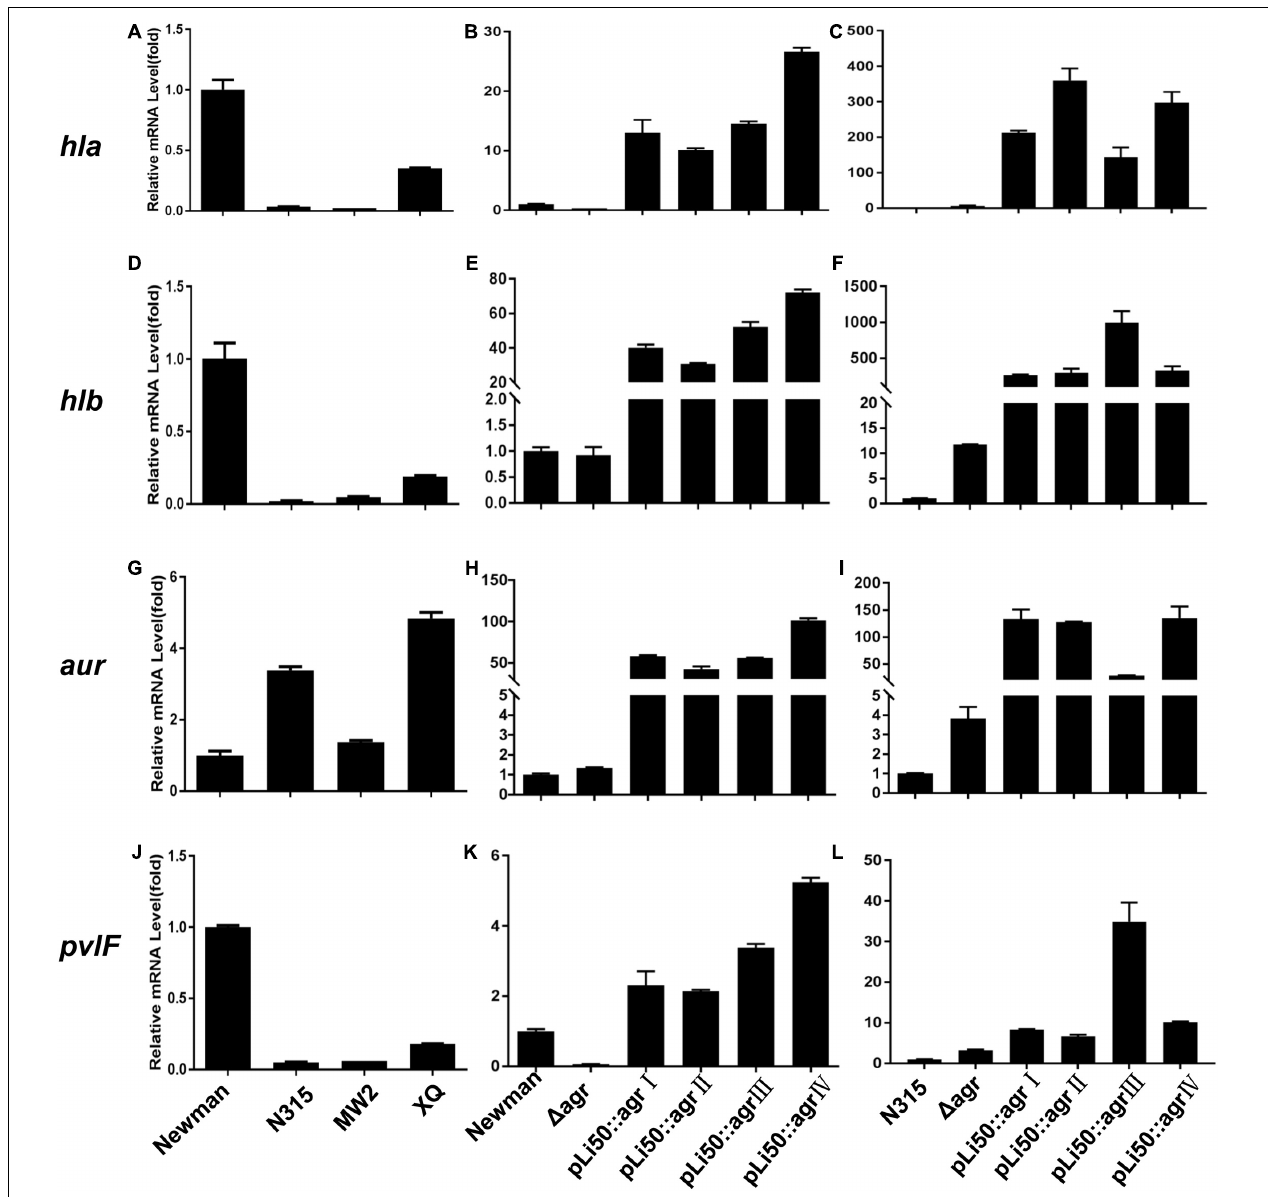
FIGURE 6 | Effects of agr alleles on virulence gene transcriptions of S. aureus. The relative transcription levels of hla (A–C) , hlb (D–F) , aur (G–I) , and pvlF (J–L) among the four wild agr allelic strains ( agr I/Newman, agr II/N315, agr III/MW2, and agr IV/XQ) (left); agr plasmid complemented congenic strains in Newman (middle); or N315 (right) background were analyzed. Error bars represent the average standard deviation (SD) of three separate